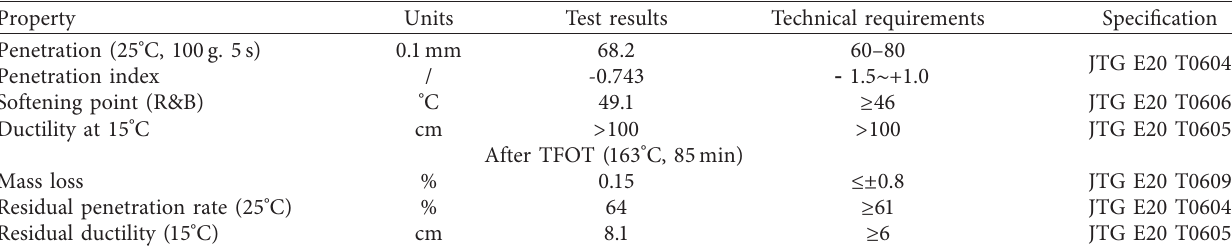
Table 1: Technical properties of asphalt binder of 70-penetration grade.